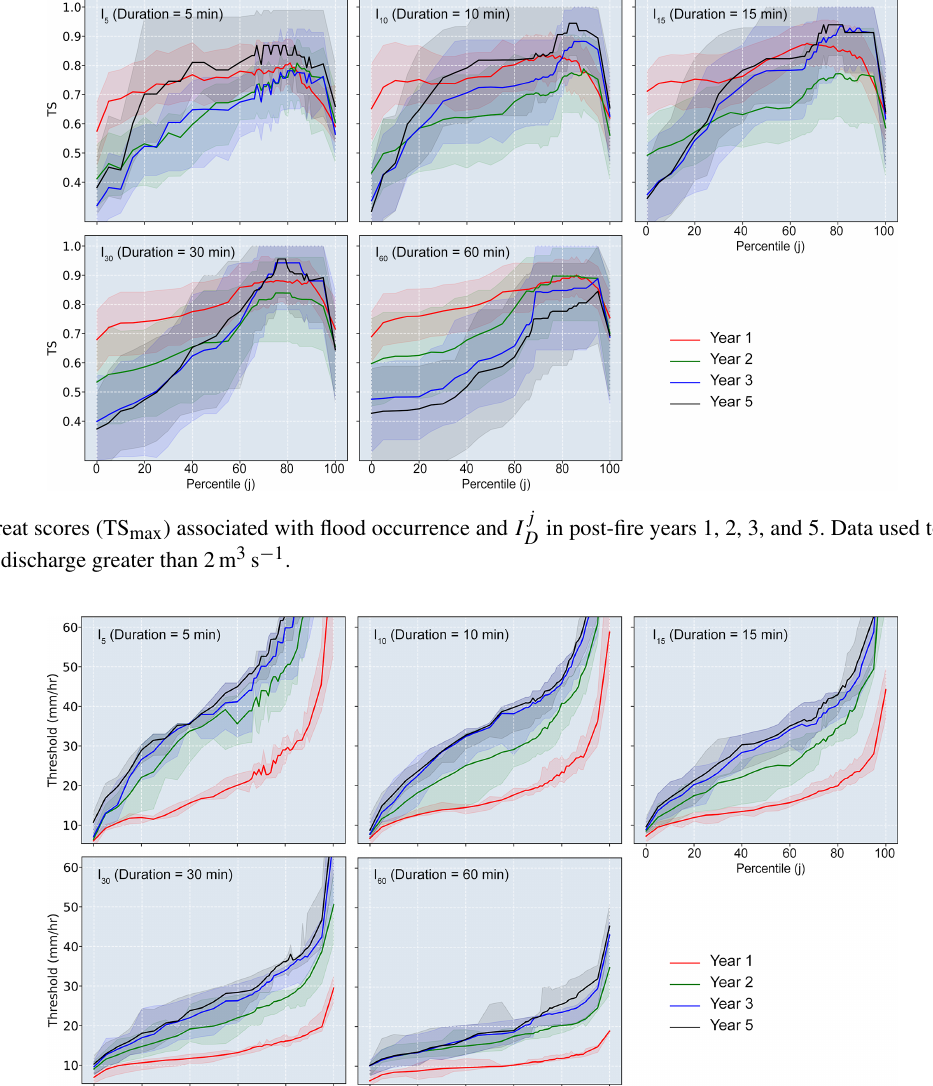
Figure 7. The rainfall intensity threshold for flash flood derived from the maximum of TS for different durations and percentiles of the most intensive rainfall field in post-fire years 1, 2, 3, and